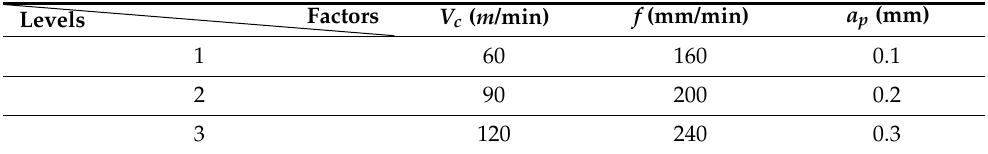
Table 2. Orthogonal experimental parameters.